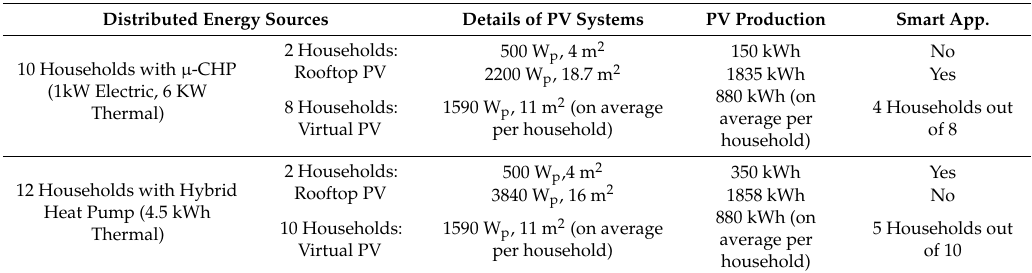
Table 1. Summary of the smart grid pilot settings and photovoltaic (PV) energy production for 2012 in PowerMatching